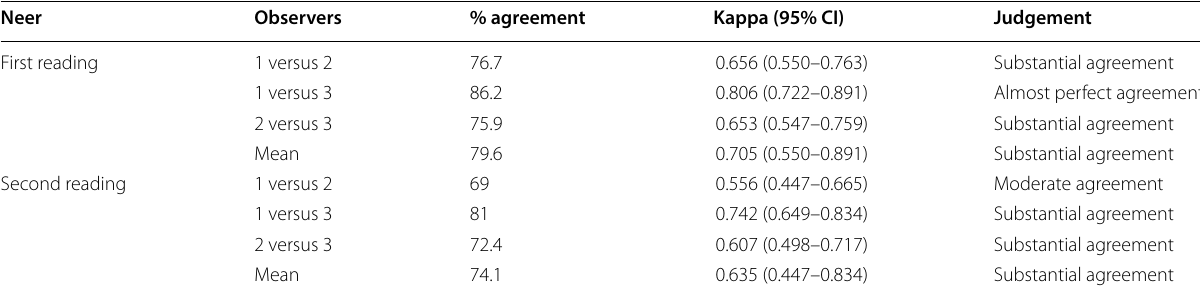
Table 1 Level of agreement among observers for the Neer classification after both review sessions